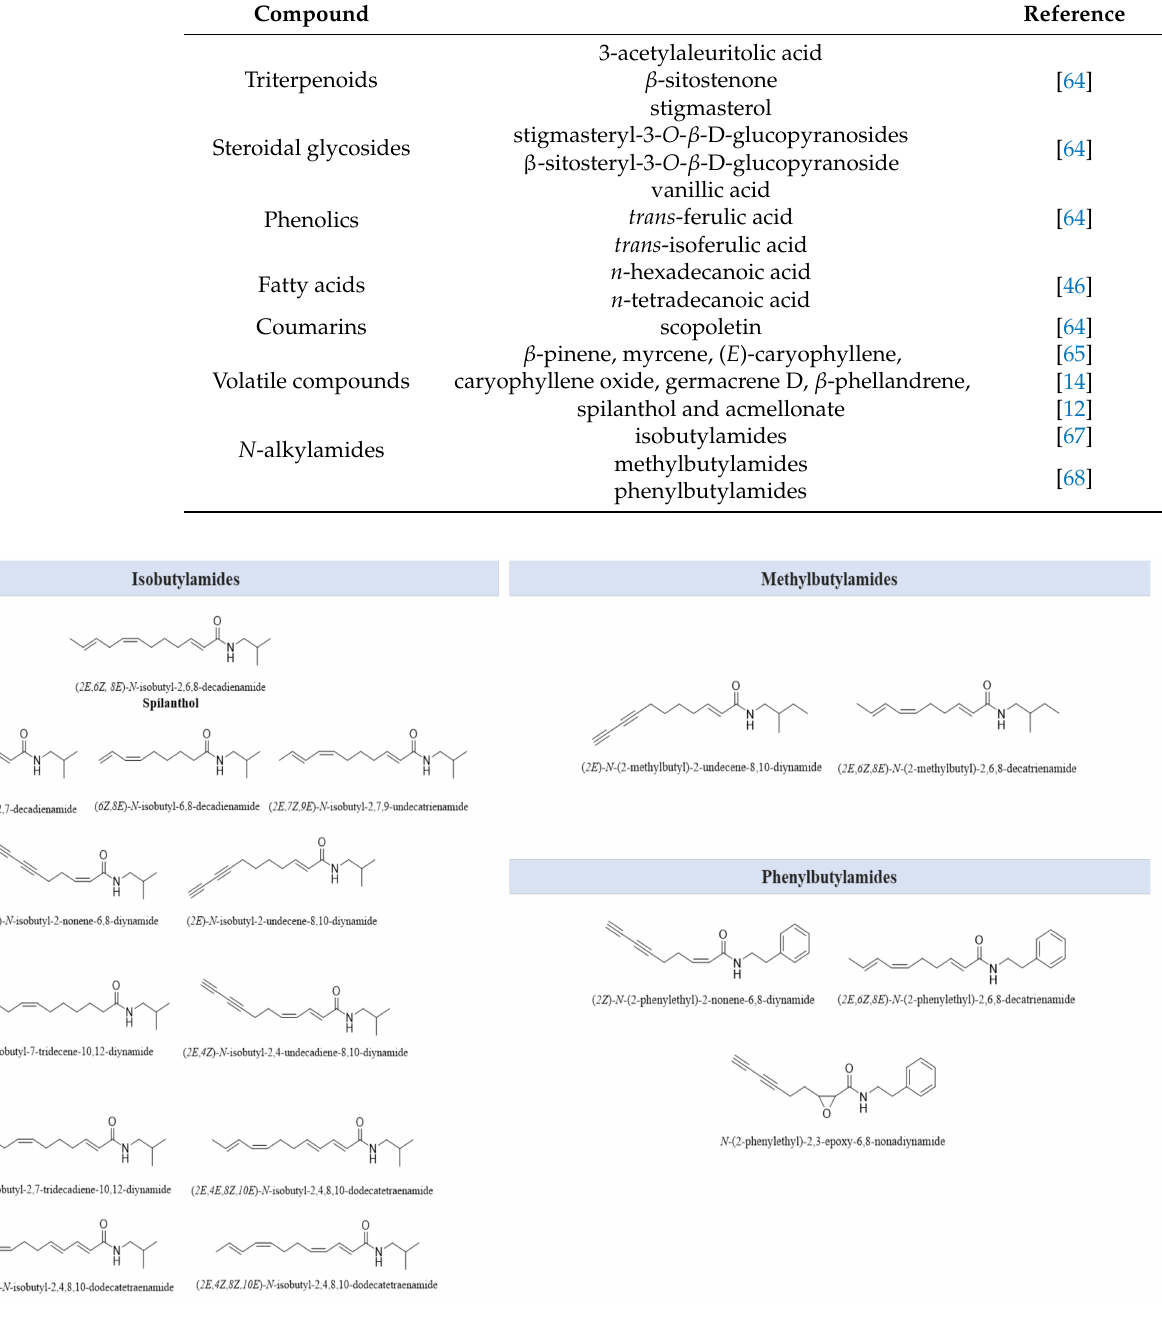
Figure 3. Main N -alkylamides found in A. oleracea